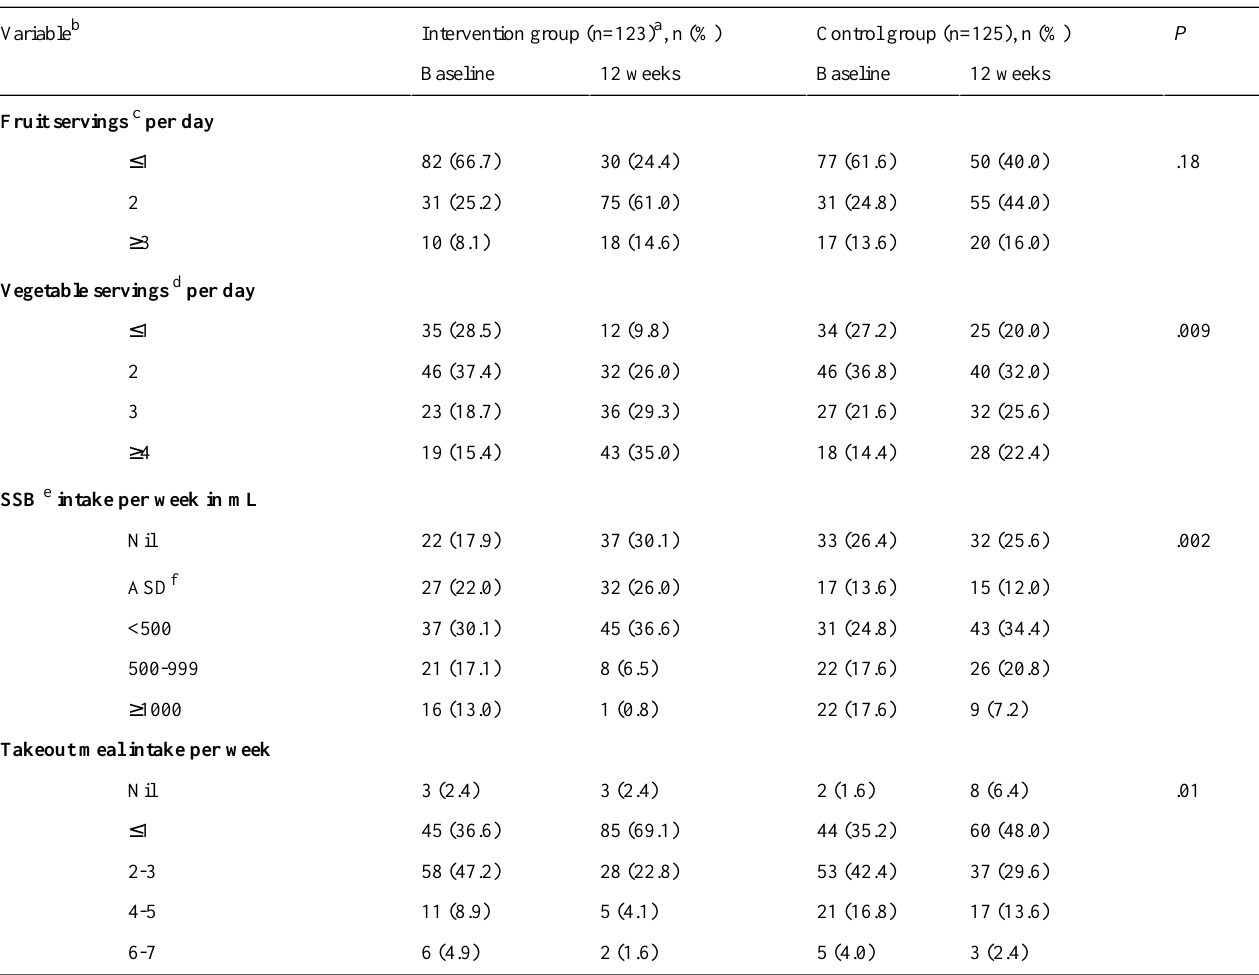
Table 4. Effect of the TXT2BFiT program on secondary outcomes for diet for all randomized participants in the study by allocation (intention-to-treat analysis) (n=248) a